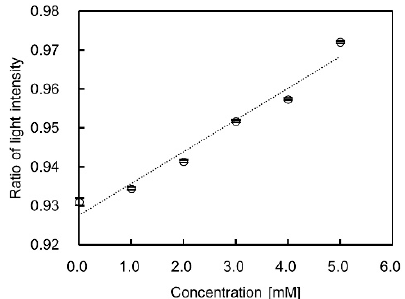
Figure 3. Optical extinction spectra acquired with the picoliter cuvette inside an optical fiber for changes in L-cysteine concentration. ( a ) and ( b ) are for gold mass concentration cases of 2 wt% and 4 wt%, respectively. The numerical value in the graph represents the concentration of L-cysteine. Figure 4. Sensitivity characteristics of L-cysteine using gold nanoparticle (GNP) dispersion solution with a gold mass concentration of 4 wt%. The white circle is the average value of ten measurements, and the bars show the maximum and minimum value in each plot.